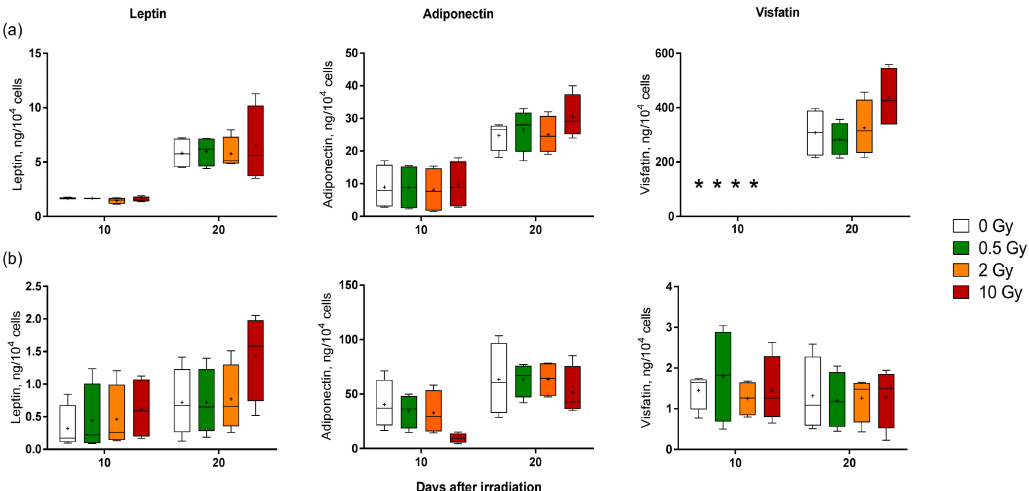
Figure 6. Effect of X-ray irradiation on the adipokine release by human adipocytes. ( a ) Human primary pre-adipocytes and ( b ) SGBS pre-adipocytes were exposed to 0.5, 2 and 10 Gy X-rays and differentiation was initiated. Cell supernatants were collected on day 10 and 20 after irradiation and the amount of adipokines leptin, adiponectin, and visfatin were measured using enzyme-linked immunosorbent assay ELISA. Boxplots show the median, Tukey whiskers (median ± 1.5 times interquartile range) and mean (+). X-axis represents days after irradiation and Y-axis is the amount of adipokines released. N = 4, * value below detection